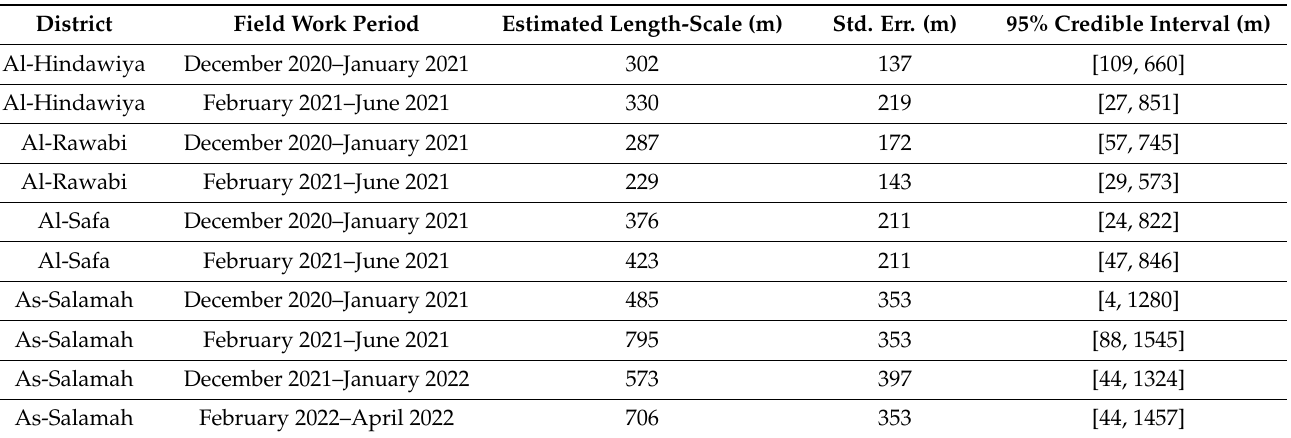
Table 1. Estimated length-scale parameters of covariance kernels in Gaussian process models for mosquito